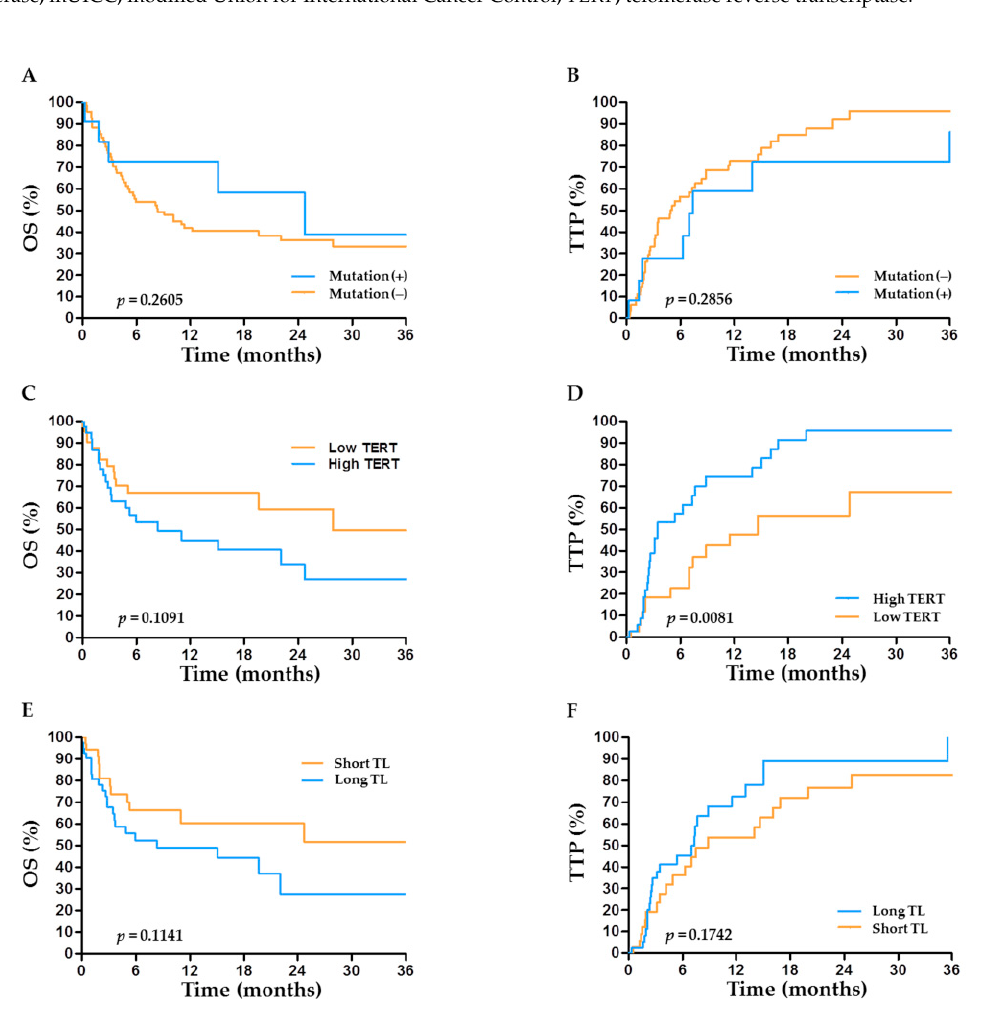
Figure 4. Prognostic role of TERT factors in the outcome of HCC after transarterial chemoembolization (TACE). Overall survival (OS) and time to progression (TTP) according to ( A , B ) the status of TERT promoter mutations, ( C , D ) the expression level of TERT , and ( E , F ) telomere length (TL).